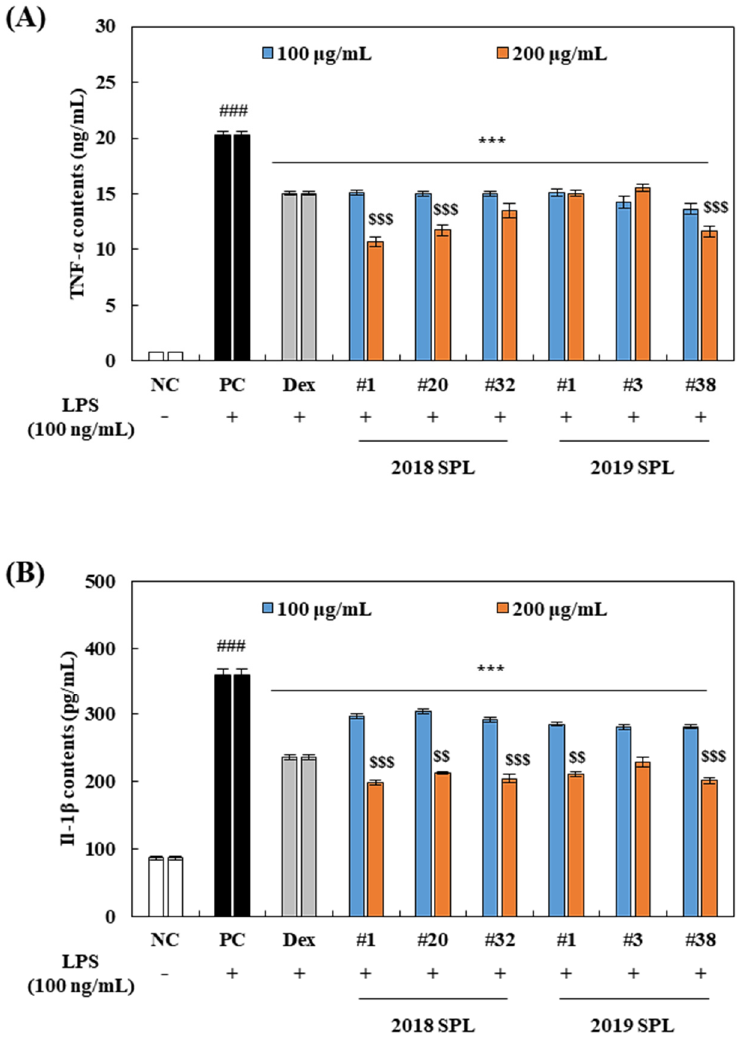
Figure 3. Effect of 2018 and 2019 SPL on production of TNF- α and IL-1 β in RAW 264.7 cells. RAW 264.7 cells were pretreated 100–200 µ g/mL of SPL and 20 µ M of dexamethasone (Dex) for 2 h, and then cells were incubated with 100 ng/mL of LPS for 24 h. LPS-induced proinflammatory cytokines, ( A ) TNF- α and ( B ) IL-1 β are measured by commercial kit with TNF- α and IL-1 β standard. Data were calculated as mean ± SEM. Significant differences are compared with control at ### p < 0.01, PC at *** p < 0.001 and Dex at $$ p < 0.01, $$$ p < 0.001 ( n = 5).